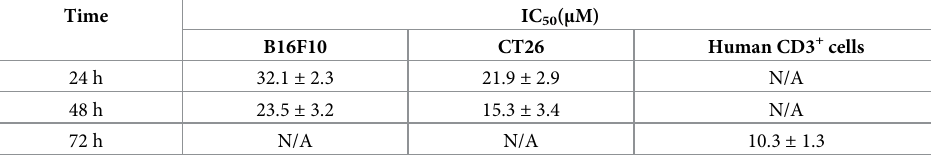
N/A, not assay. IC 50 values were calculated using Graph Pad Prism v 5.0. The results were presented as mean ± S.D (n = 3).